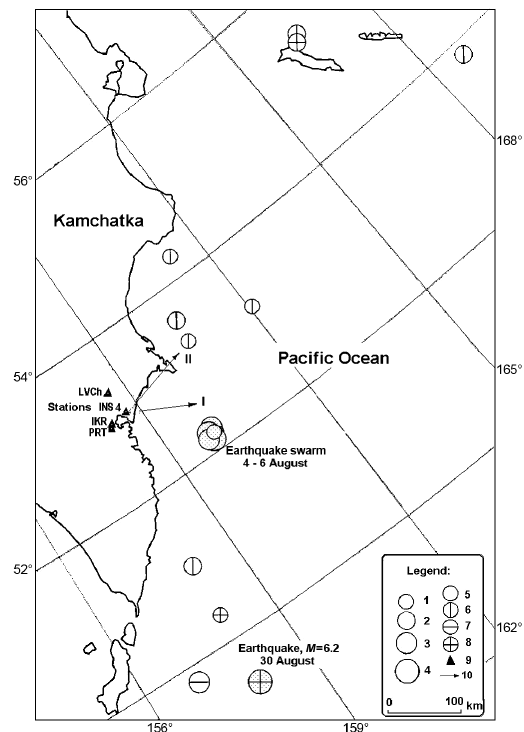
Fig. 1. The scheme of location of radon monitoring stations over the period of July-August 2004 and earth- quake’s epicenters for the period of July 12-September 1, 2004, with energy class ( K ): 1 – 11; 2 – 12; 3 – 13; 4 – 14; and a focal depth: 5 – 0-19; 6 – 20-39; 7 – 40- 59; 8 – 60-100 km; 9 – monitoring stations; 10 – azi- muth to the